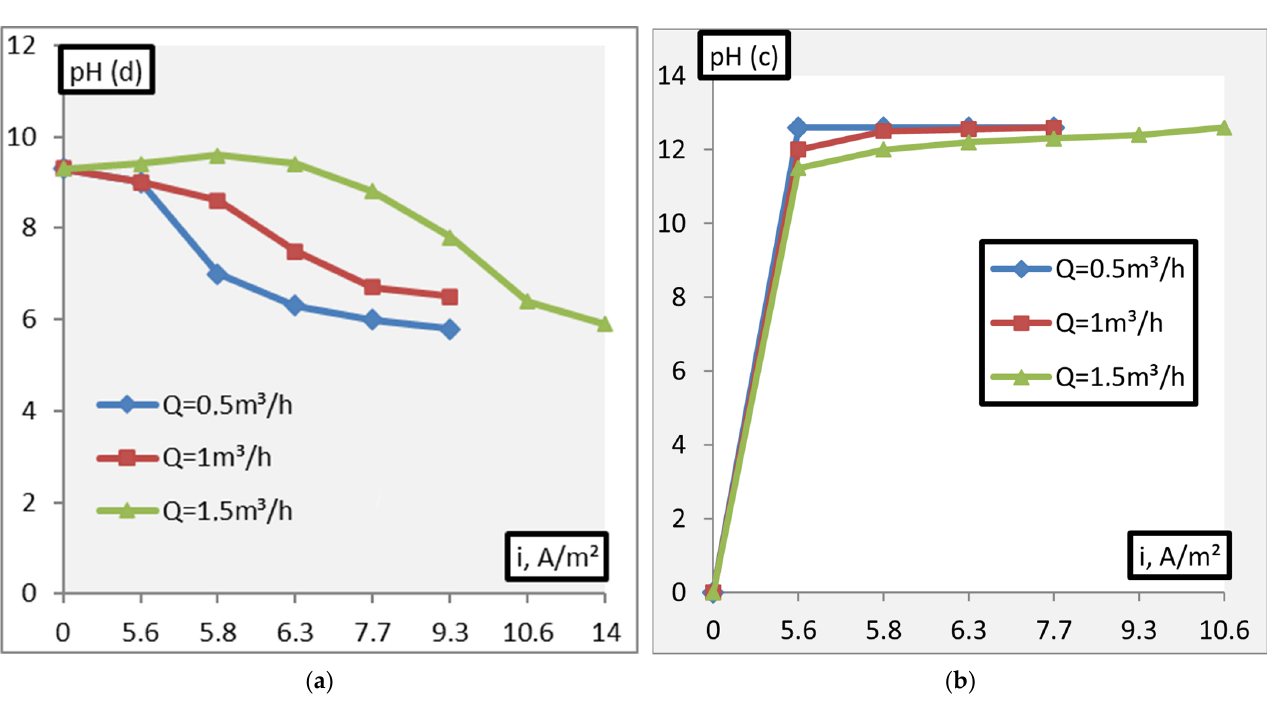
Figure 8. Dependence of the pH. (( a )—pH(d), ( b )—pH(c)) adjustment of alkaline solutions on the current density and process performance (initial pH = 9.3)